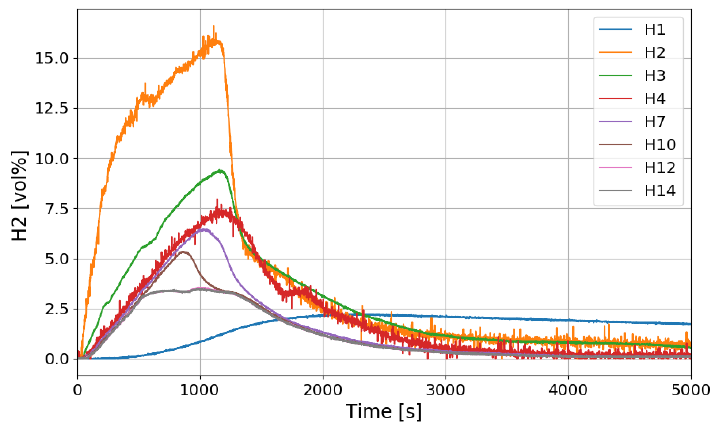
Figure 20. Hydrogen concentration distributions along a center line for the SP5 test.